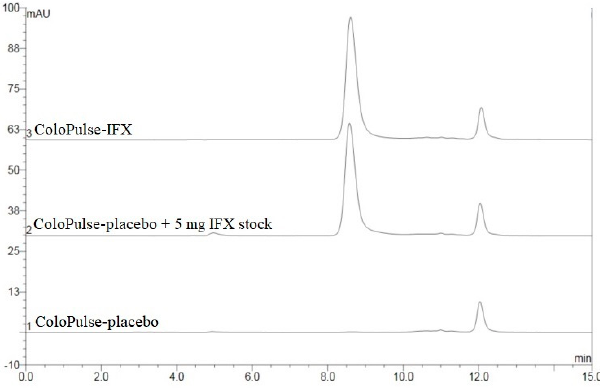
Figure 1. Representative HPLC-SEC chromatograms of ColoPulse-IFX, ColoPulse-placebo, and ColoPulse-placebo spiked with 5 mg fresh IFX stock.